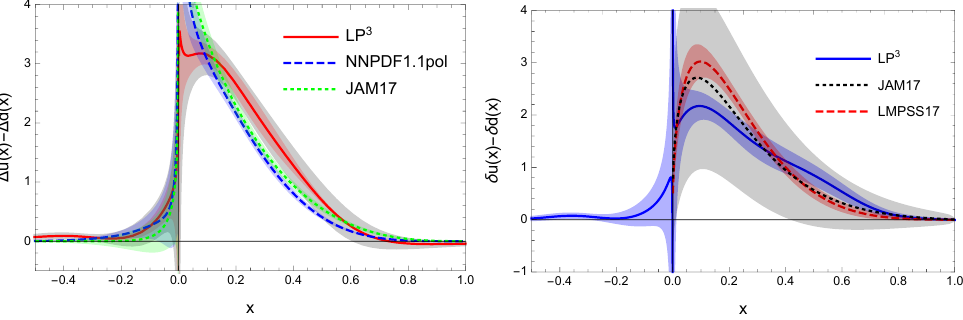
Figure 2. (Left) LP 3 ’s isovector quark helicity PDF [45] matched in MS-scheme at scale µ = 3 GeV, extracted from LaMET at the largest proton momentum (3 GeV), compared with fits by NNPDFpol1.1 [51] and JAM [52]. The red band contains statistical error, while the gray band also includes systematics. (Right) LP 3 ’s proton isovector transversity PDF [46] at renormalization scale µ = √ 2 GeV (MS scheme), extracted from lattice QCD and LaMET at P z = 3 GeV, compared with global fits by JAM17 and LMPSS17 [53]. The blue error band includes statistical errors (which fold in the excited-state uncertainty) and